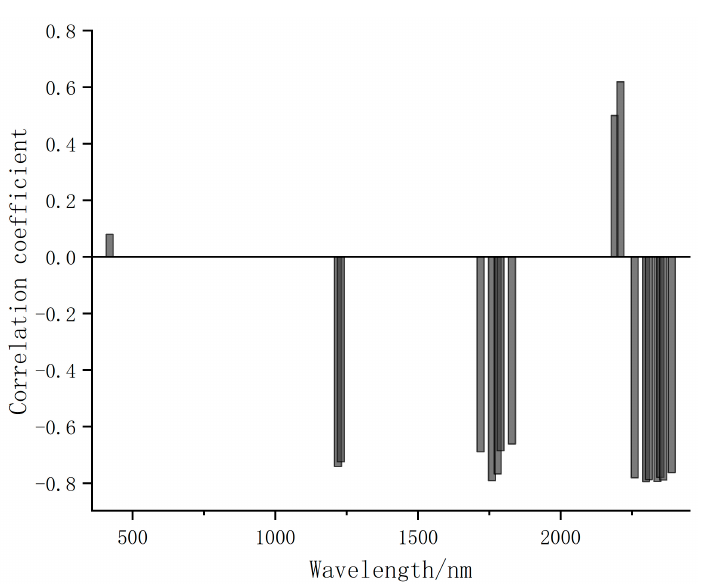
Figure 6. Scatter plots of the predicted versus measured soil petroleum hydrocarbon content: ( a ) Initial-PLSR; ( b ) CR-PLSR; ( c ) CR-GARF-PLSR; ( d ) CR-GARF-KNN.